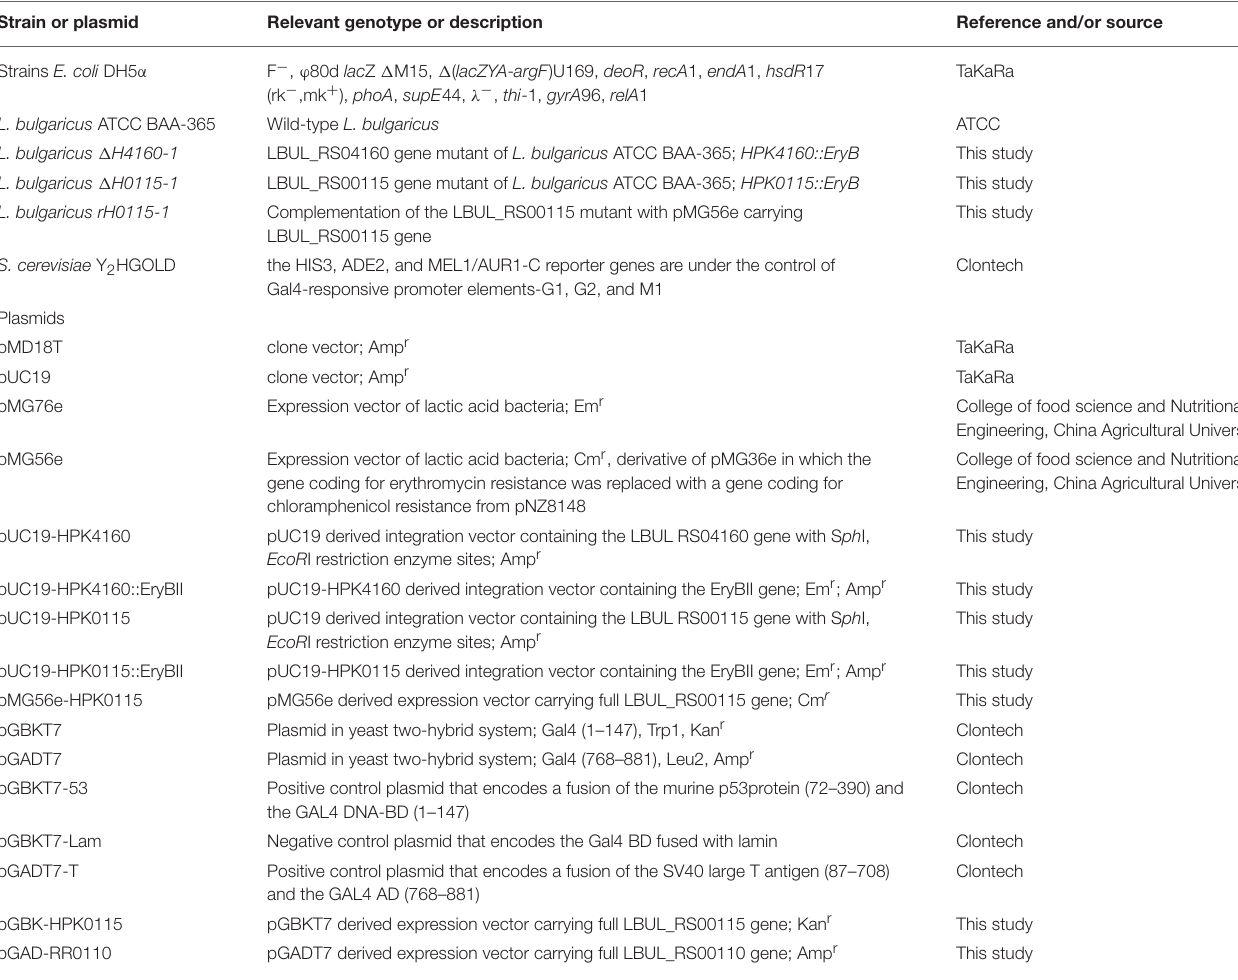
TABLE 1 | Bacterial strains and plasmids used in this study. Strain or plasmid Relevant genotype or description Reference and/or